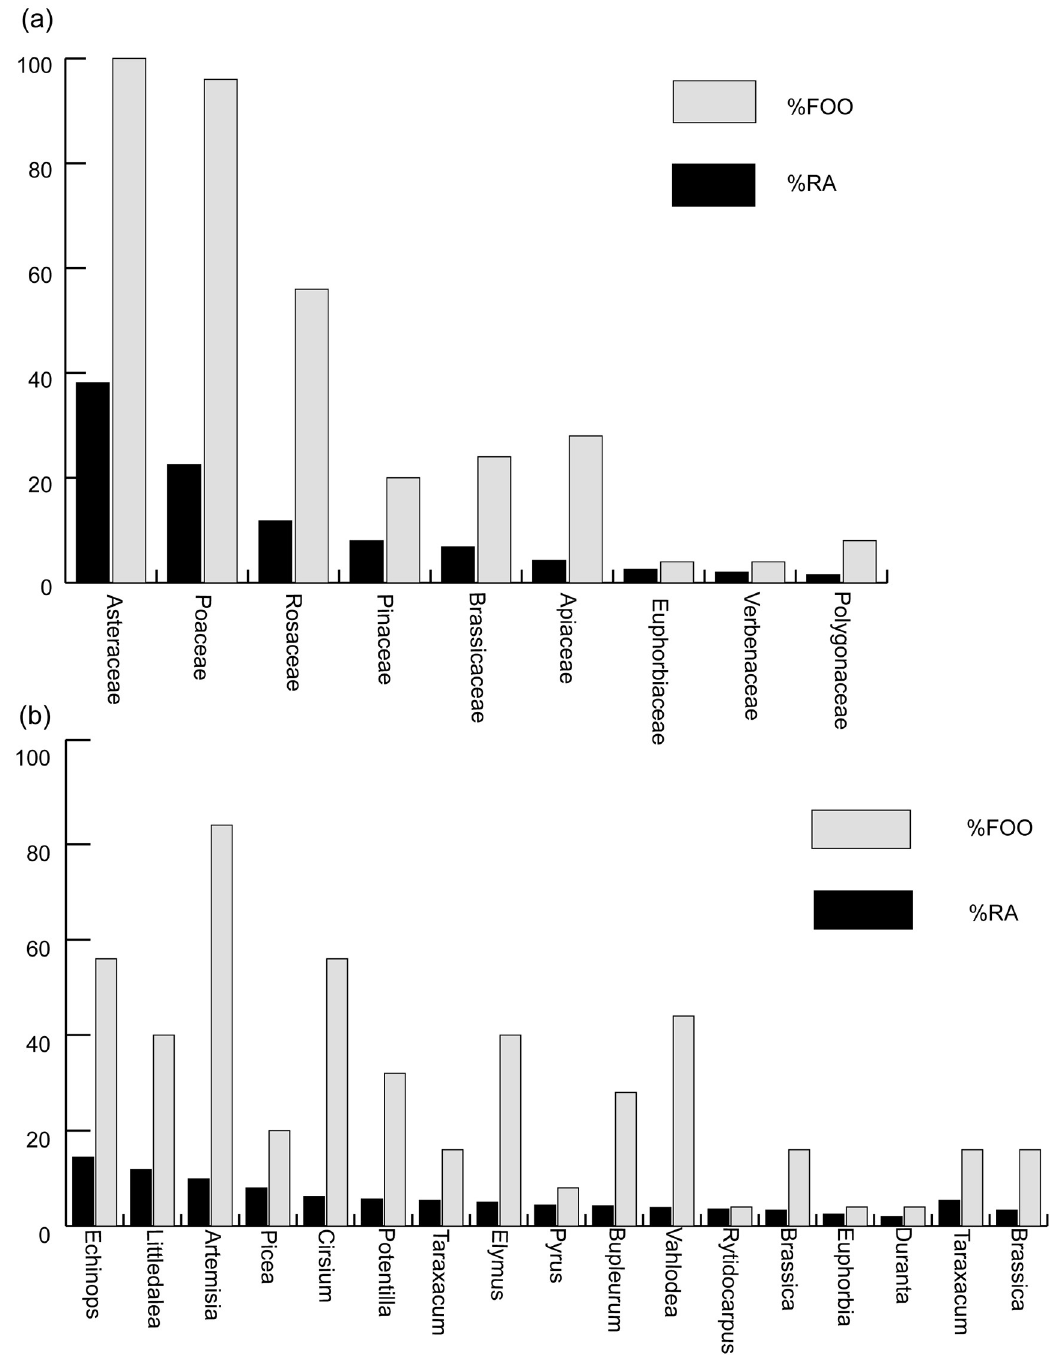
Fig 3. %RA and %FOO of plant families and genera. a and b respectively show that zokors mainly fed on families of the Poaceae, Asteraceae, and Rosaceae and genera of the Echinops , Artemisia , Picea , and Cirsium .